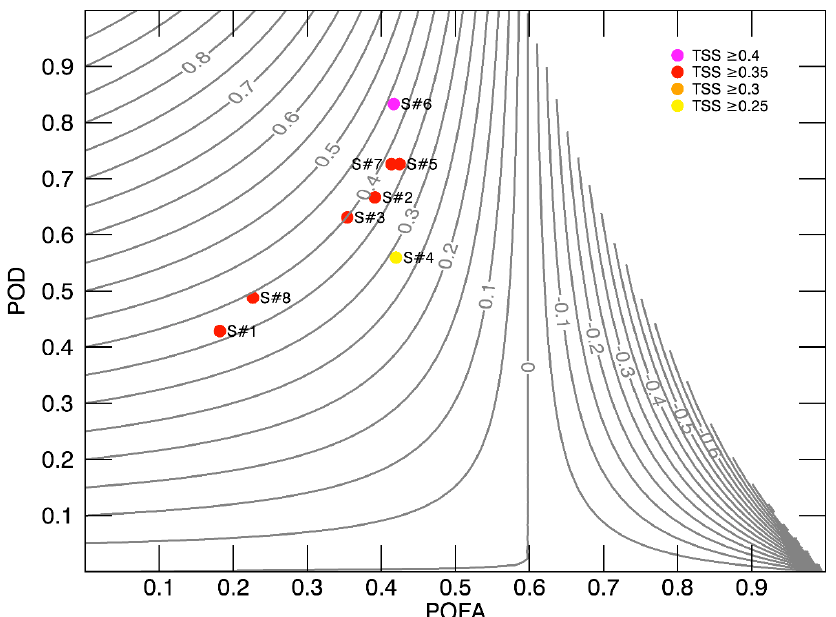
Figure 6. TSS for the radar signatures’ threshold with maximum TSS (contours), presented in terms of POD and POFA. Radar signatures are S#1: Z dr column maximum height; S#2: Precipitation ice signature maximum height; S#3: VII; S#4: Height of peak Z h above the 0°C isotherm level; S#5: Peak Z h above the 0°C isotherm level; S#6: Peak Z h within the storm; S#7: VIL; S#8: DVIL.